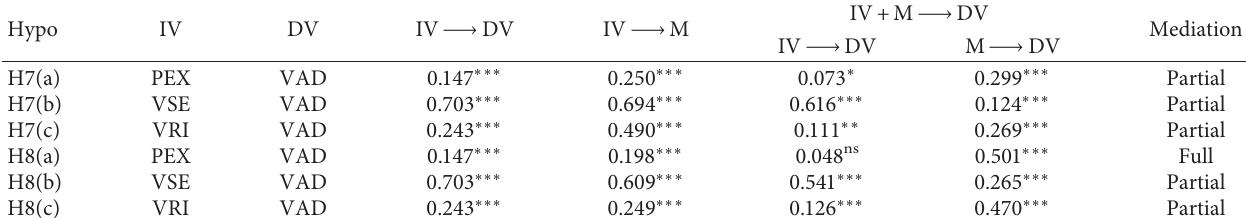
Table 8: Mediation (as advised by Baron and Kenny’s approach).